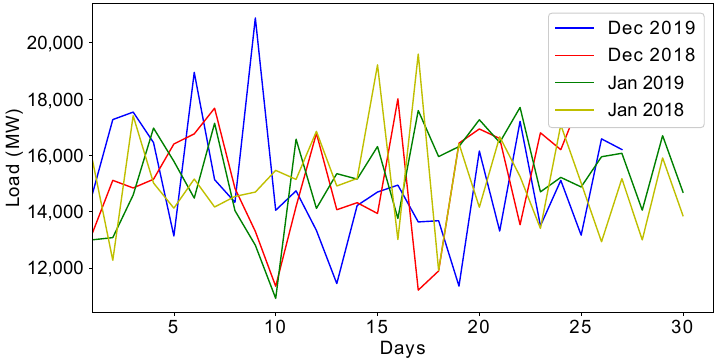
Figure 12. Similar months load